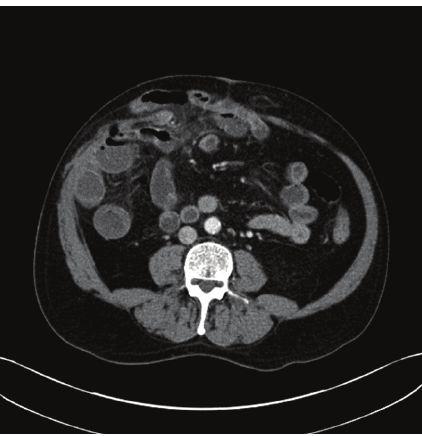
Figure 1: A CT image demonstrating the recurrent incisional hernia containing bowel